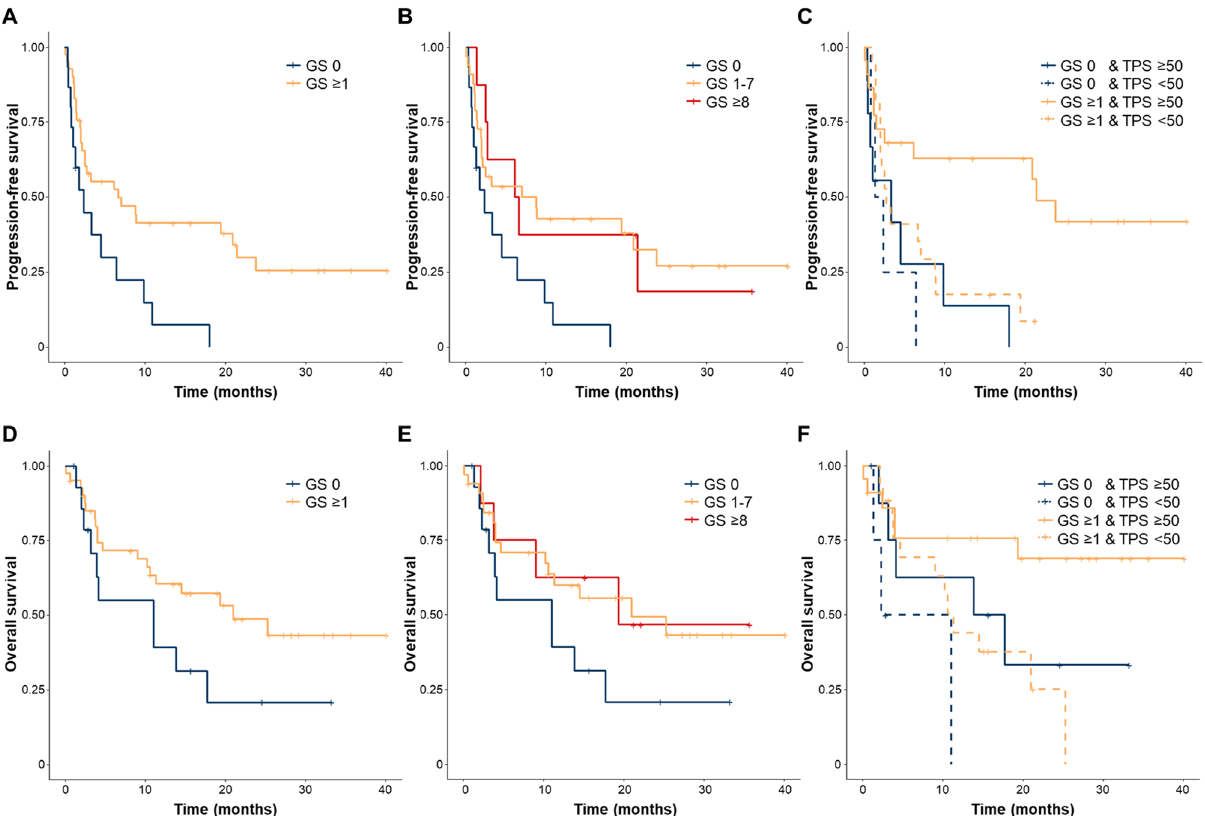
Figure 2. ( A ) Kaplan–Meier plot of the progression-free survival (PFS) in patients with or without emphysema (GS ≥ 1 vs GS = 0). ( B ) PFS in patients without emphysema (GS = 0), with mild emphysema (GS 1–7), or moderate emphysema (GS ≥ 8). ( C ) PFS in patients with or without emphysema, according to whether the PD-L1 expression is high or not. ( D ) Kaplan–Meier plot of the overall survival (OS) in patients with or without emphysema (GS ≥ 1 vs GS = 0). ( E ) OS in patients without emphysema (GS = 0), with mild emphysema (GS 1–7), or moderate emphysema (GS ≥ 8). ( F ) OS in patients with or without emphysema, according to whether the PD-L1 expression is high or not. GS Goddard score.